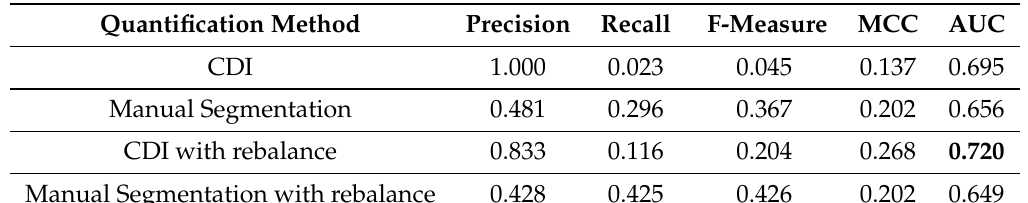
Table 8. Prediction performance of ANN using all 9 CDI locations and manual segmentation at whole medial tibia.